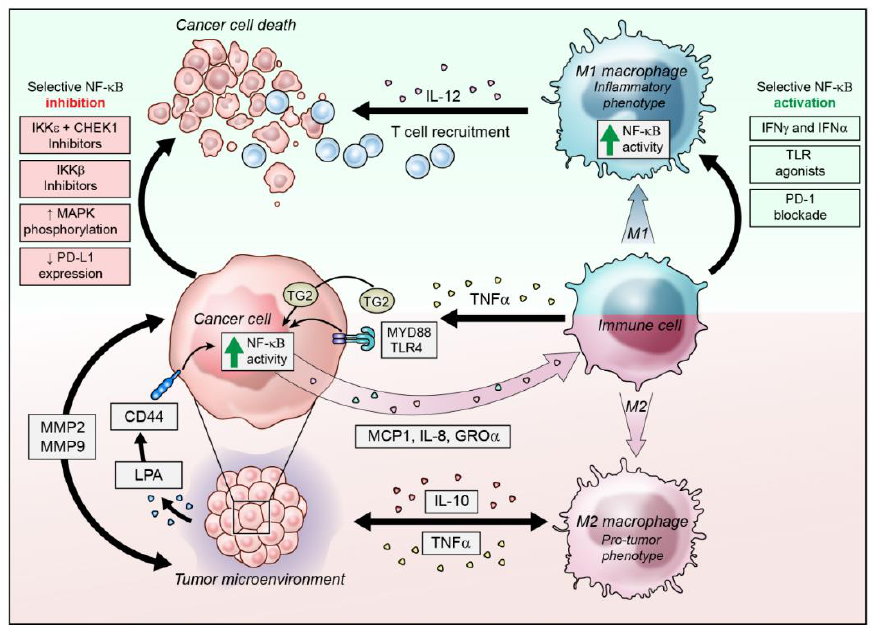
Figure 1. Strategies to target NF- κ B in ovarian cancer. NF- κ B signaling in cancer cells can be activated by interacting proteins in the tumor microenvironment, such as lysophosphatidic acid (LPA) signaling through CD44 to promote NF- κ B activity and cytokine secretion. NF- κ B signaling can also be activated by TNF α binding to cell surface receptors Myd-88 and TLR4, or through TNF α independent receptors such as TG2. NF- κ B activity promotes cytokine secretion to dampen immune responses and switch macrophages from inflammatory M1 phenotypes to M2 immunoinhibitory